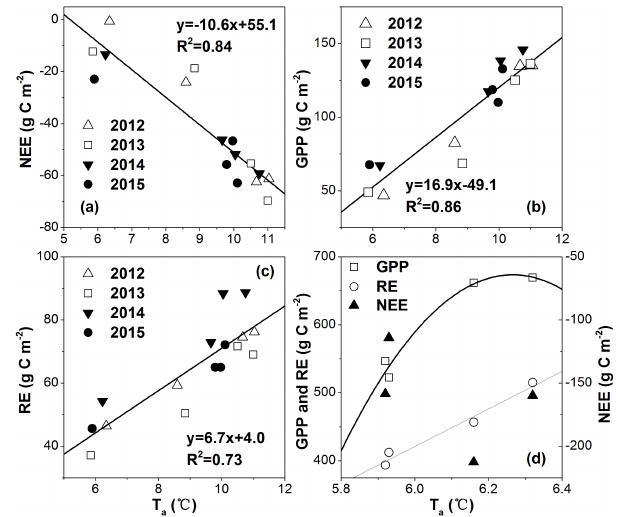
Figure 9. Relationships between (a) NEE and T a ; (b) GPP and T a ; (c) RE and T s from July to October at a monthly scale and (d) re- lationship between the annual total CO 2 exchange fluxes and the mean annual T a , which were GPP =− 1191 T 2 a + 14930 T a − 46102, R 2 = 0.97 and RE = 276 T a − 1235, R 2 = 0.97.